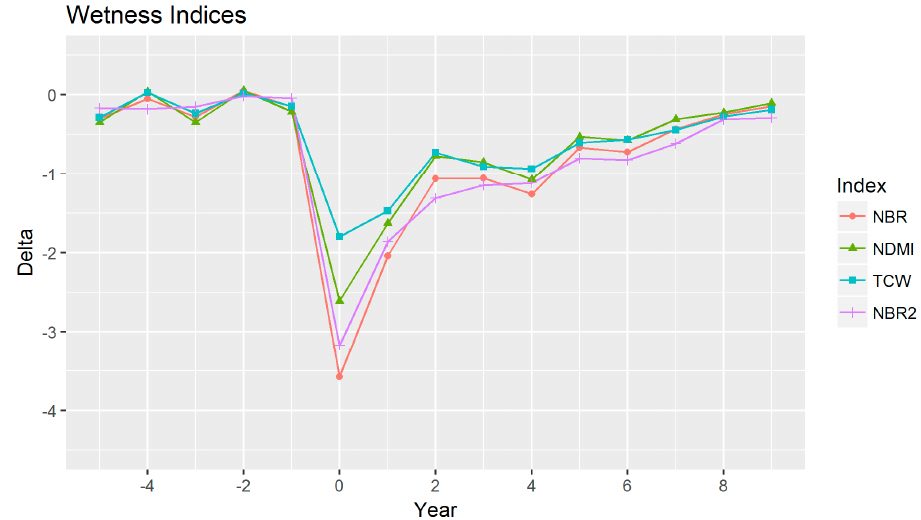
Figure 6. Mean values for wetness indices from five years prior to fire to nine years post-fire. Table 5. Average number of years to recover.